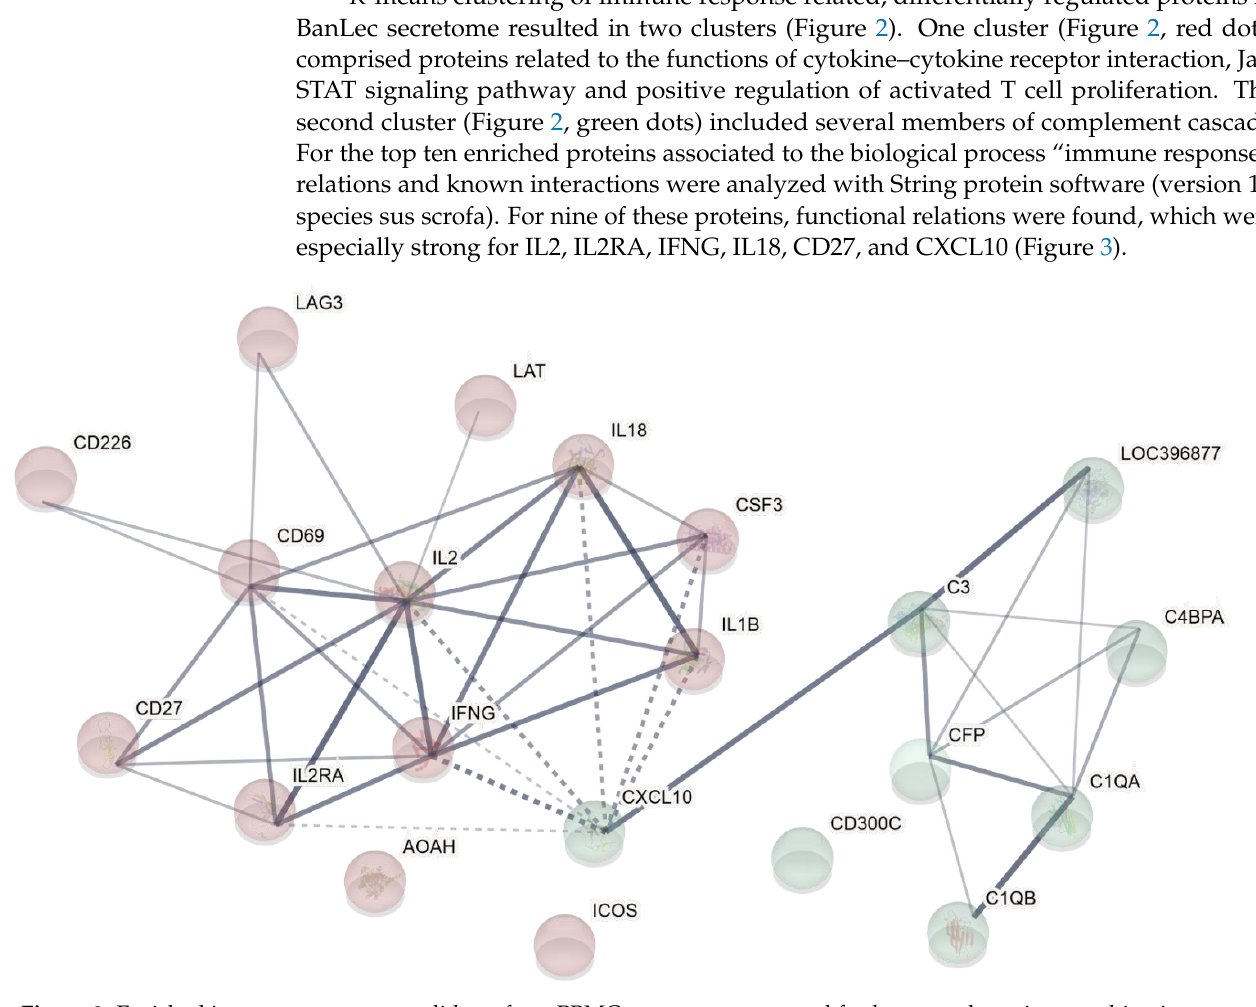
Figure 2. Enriched immune response candidates from PBMC secretome were used for k -means clustering, resulting in two distinct clusters (red and green), visualized with open source software String version 11.0.